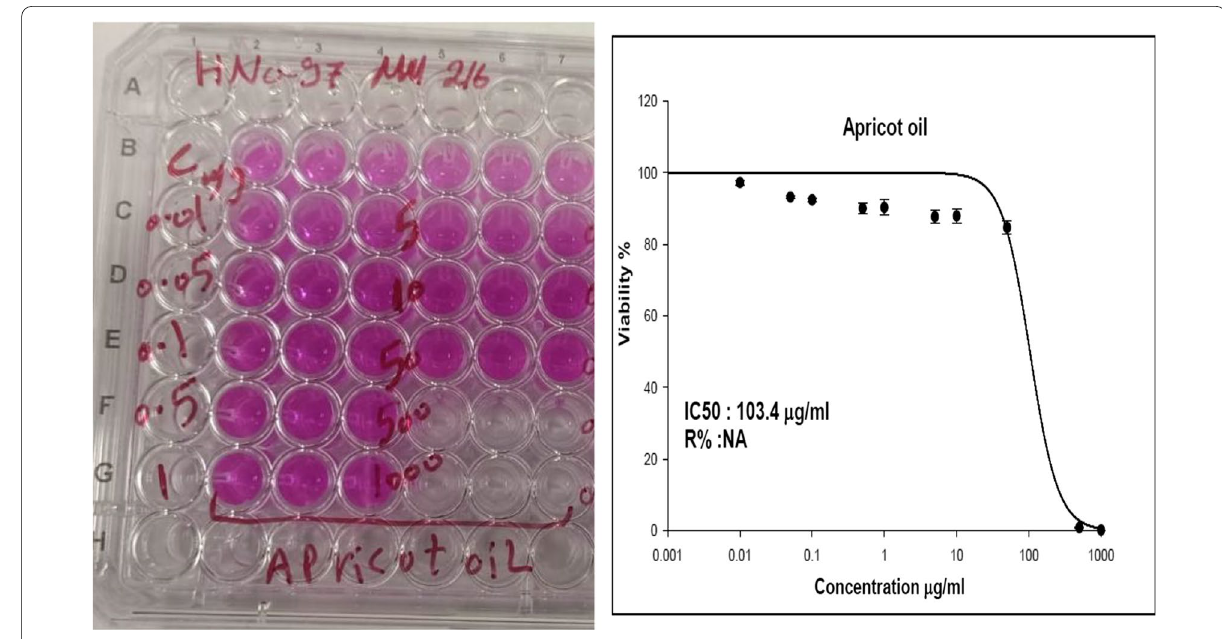
Fig. 1 SBR assay to calculate cytotoxicity of apricot oil extract and determine